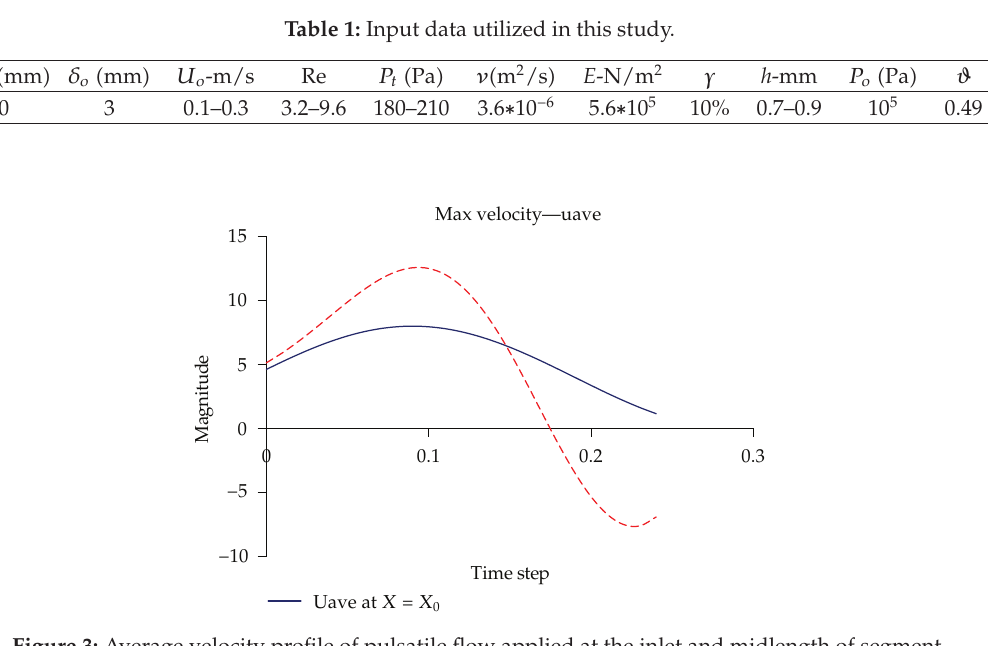
Figure 3: Average velocity profile of pulsatile flow applied at the inlet and midlength of